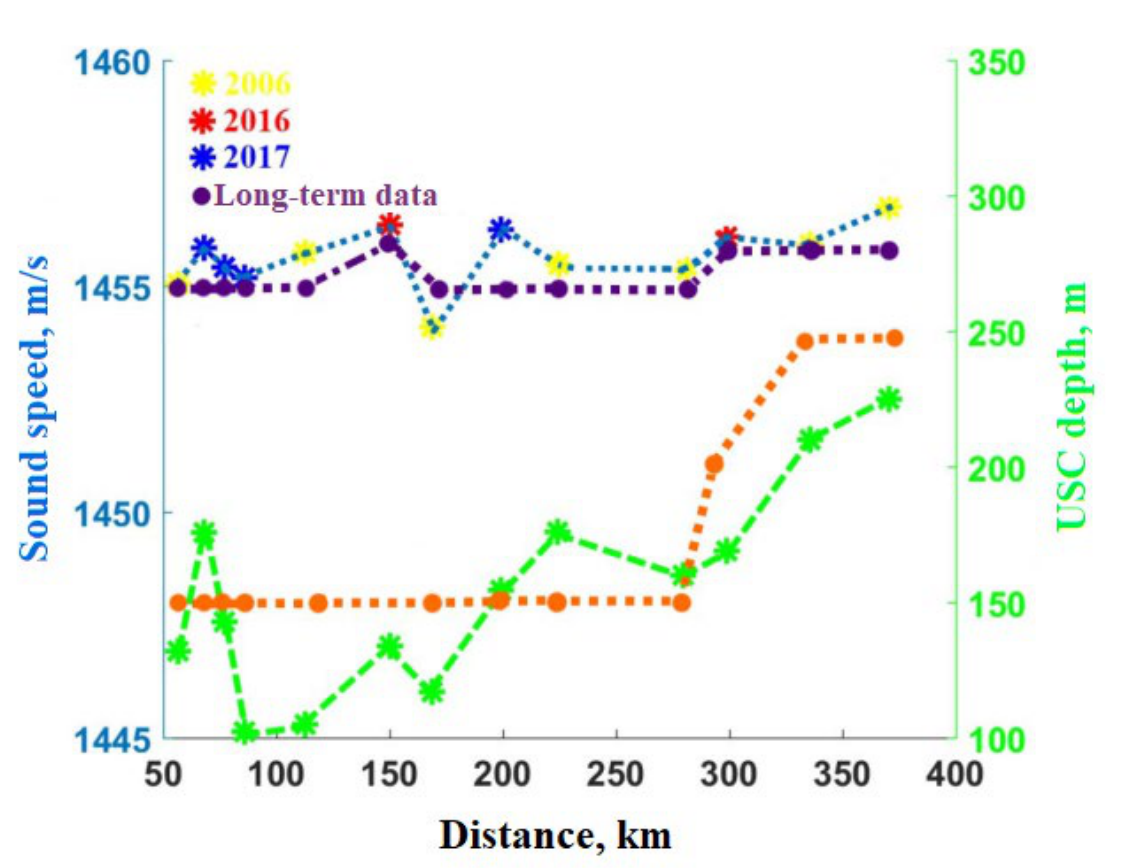
Figure 13. Dependences of changes in the sound speed on the USC axis and the depth of the axis from a distance were obtained experimentally and from long-term data.